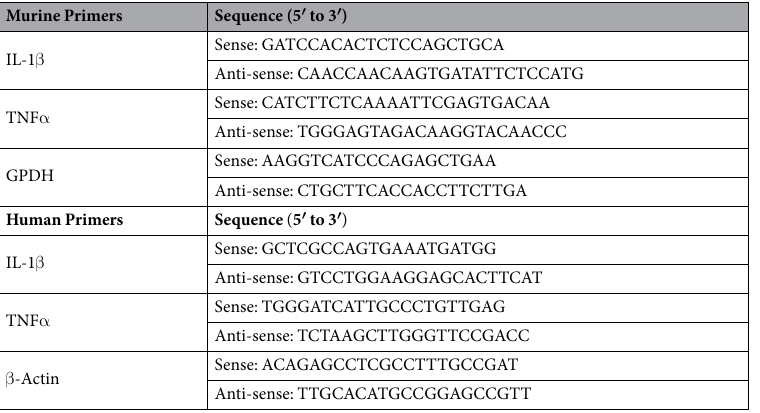
Table 1. Primers used in the qPCR